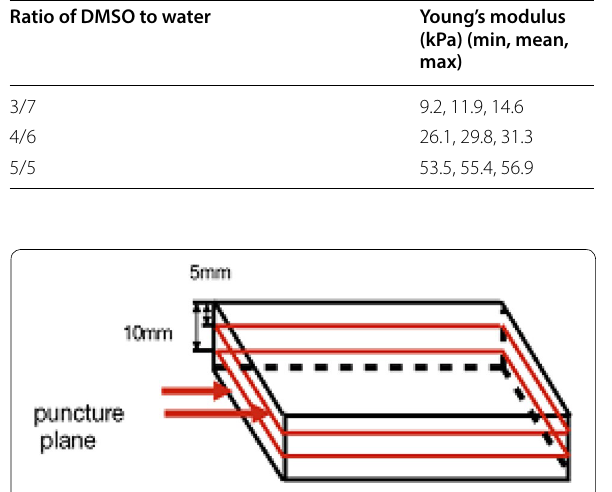
Figure 7 Different insertion